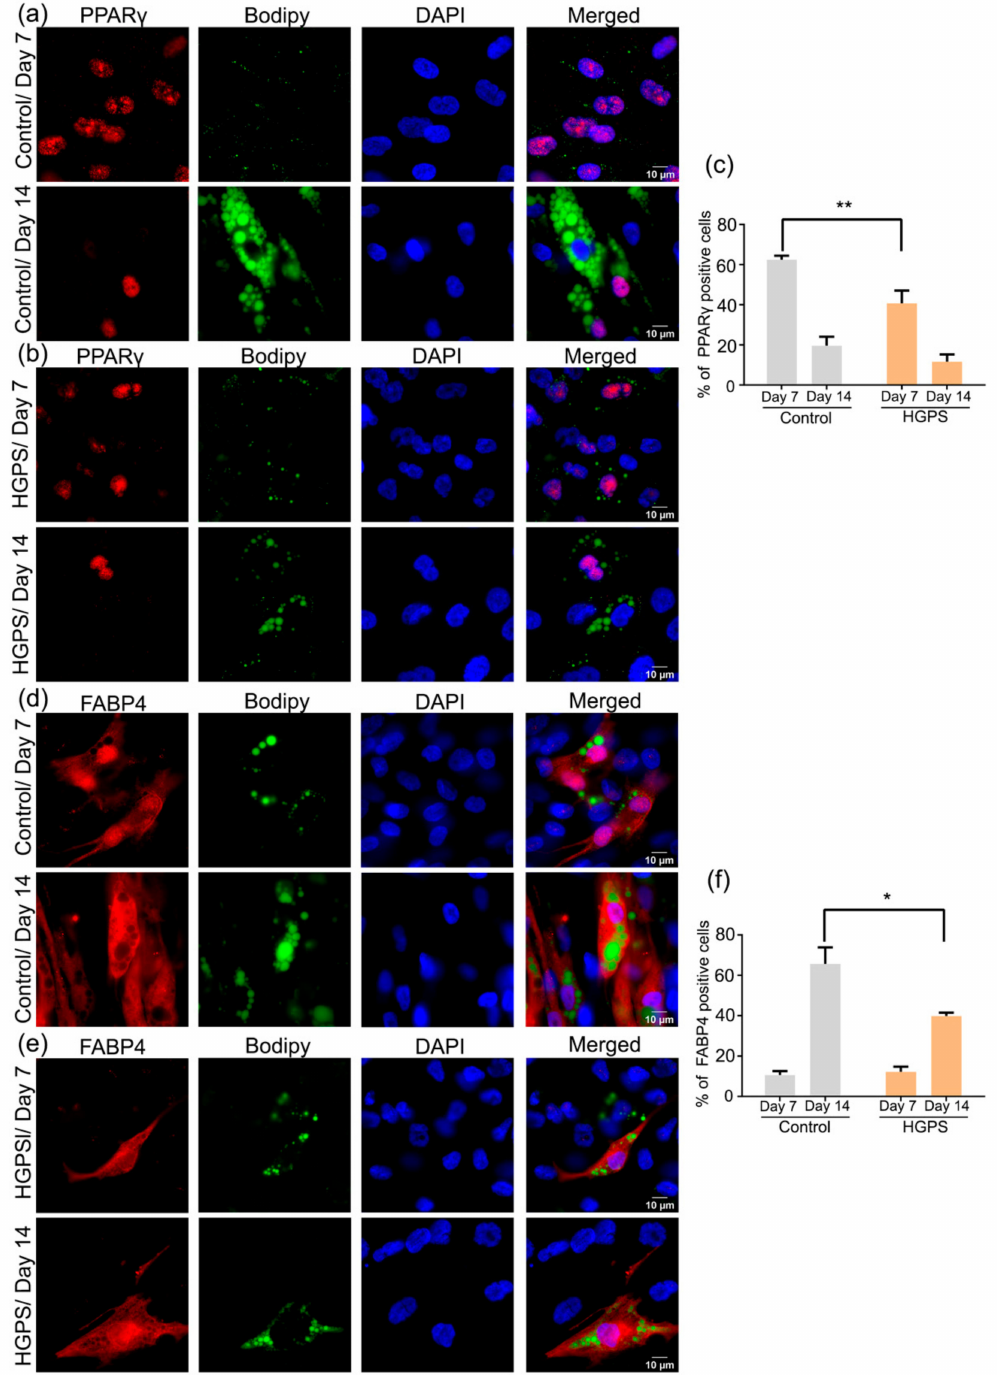
Figure 8. Expression of adipogenic markers in control and HGPS differentiated adipocytes. ( a , b ) Immunofluorescence showing the dual PPAR γ and Bodipy staining in control (GMO5567A) and HGPS (HGADFN127) adipocytes at days 7 and 14 of differentiation. ( c ) Quantification of the percentage of PPAR γ -positive cells at days 7 and 14 of differentiation in both control and HGPS differentiated SKPs. ( d , e ) FABP4 and Bodipy staining in control (GMO5567A) and HGPS (HGADFN127) differentiated adipocytes at days 7 and 14. Scale bar: 10 µ m. Cells were counterstained with DAPI. Values are presented as mean ± SD ( n = 3), * p < 0.05, ** p < 0.01, ( c , f ) two-way ANOVA with Tukey’s multiple comparisons